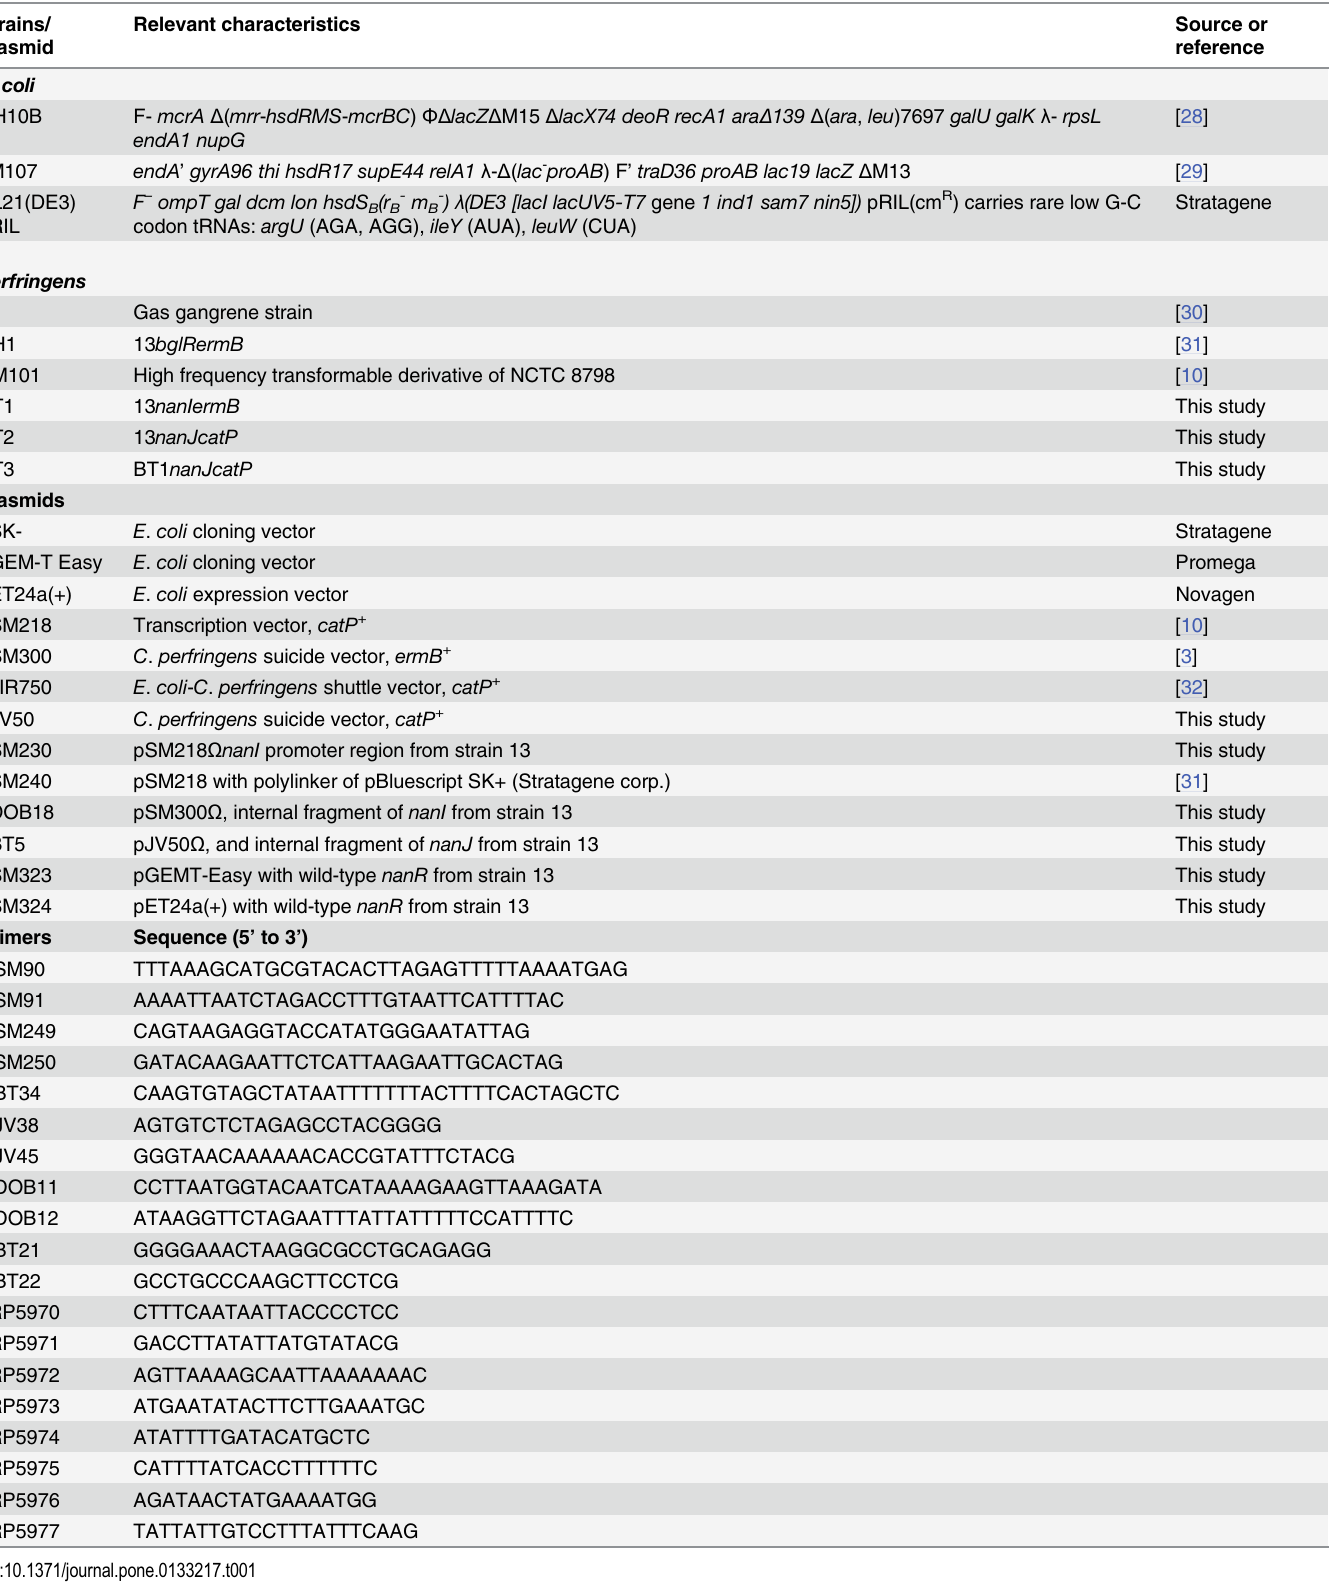
Table 1. Strains, plasmids and primers. Strains/